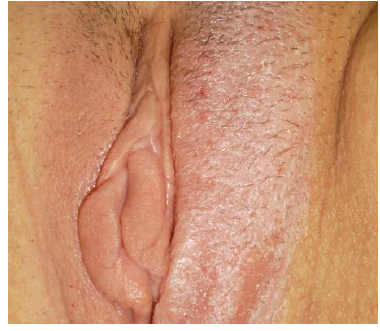
Figure 18. Psoriasis.